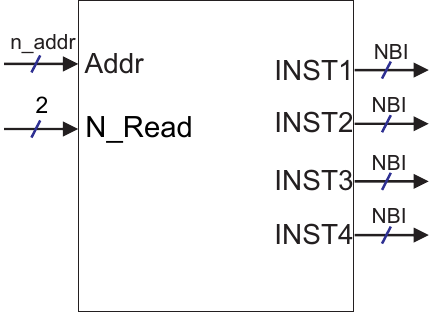
Figure 4. Logic block for the program